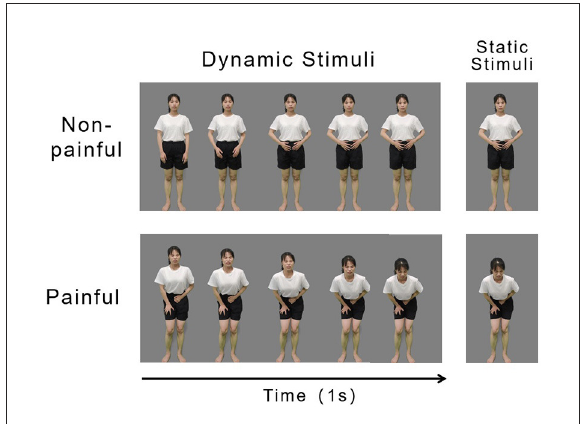
FIGURE1 Examples of non-painful (Top) and painful (Bottom) stimuli. Examples of dynamic (Left) and static (Right)